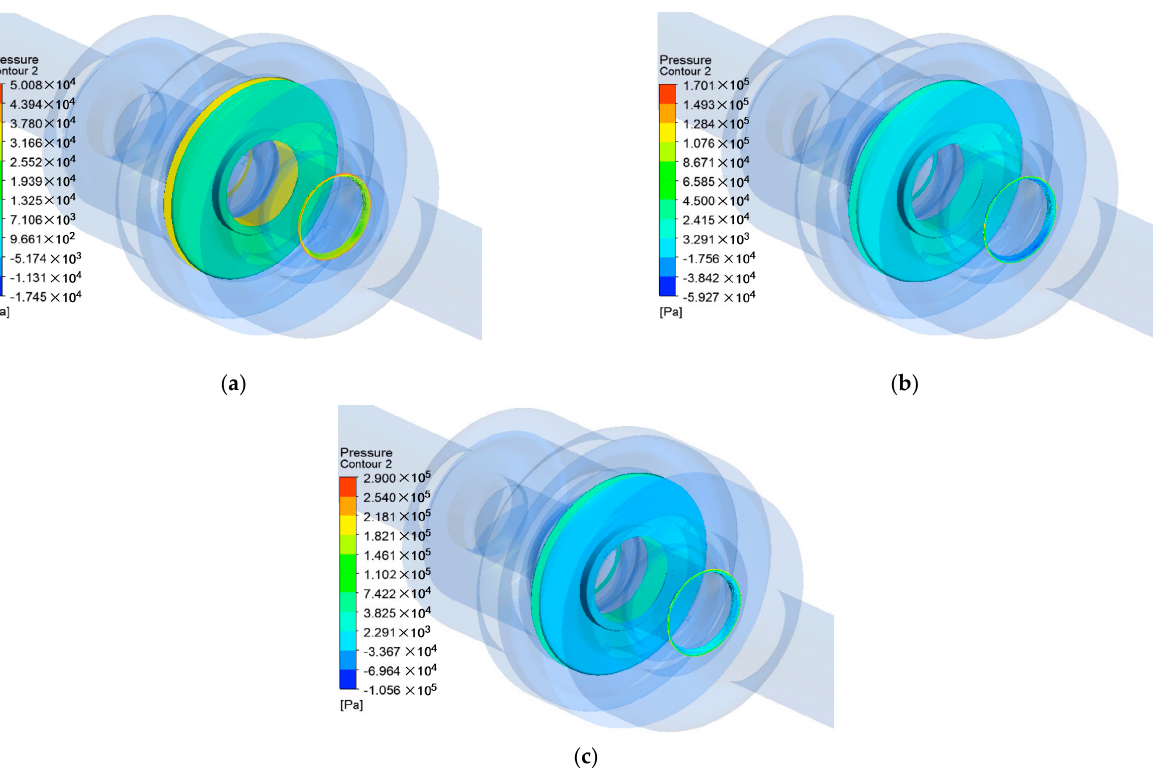
Figure 13. Dynamic flow balance valve spool axial hydrodynamic force. ( a ) ∆ P = 30 kPa, the 0 s moment of the moving mesh. ( b ) ∆ P = 150 kPa, the 0.26 s moment of the moving mesh. ( c ) ∆ P = 270 kPa, the 0.53 s moment of the moving mesh.